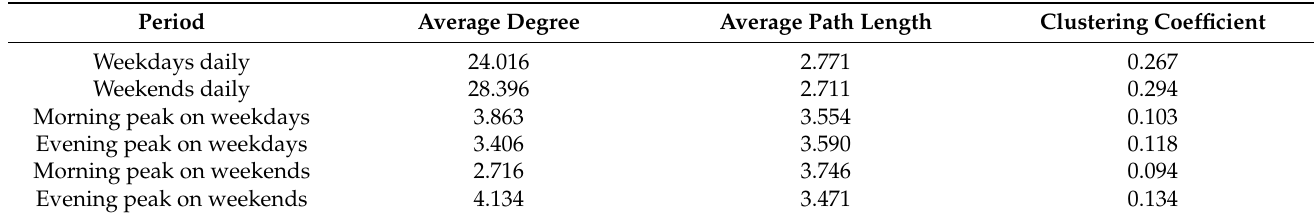
Table 3. Statistical description of taxi flow